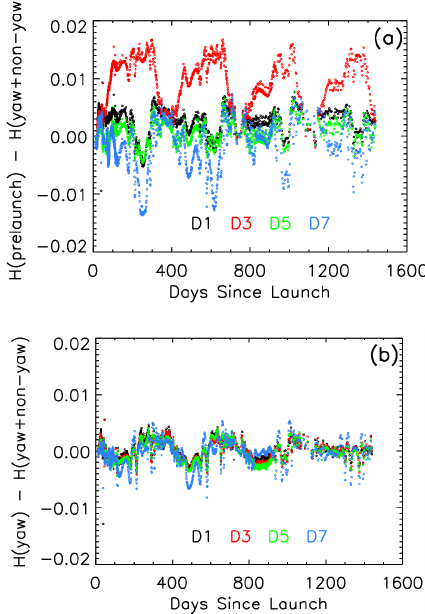
Figure 9. The difference in the H-factors using the SDSM screen transmission functions for the odd-numbered detectors derived from prelaunch data ( a ) and from the yaw maneuver data only ( b ) relative to the H-factor using the SDSM screen transmission functions derived from both yaw maneuver and regular on-orbit data.